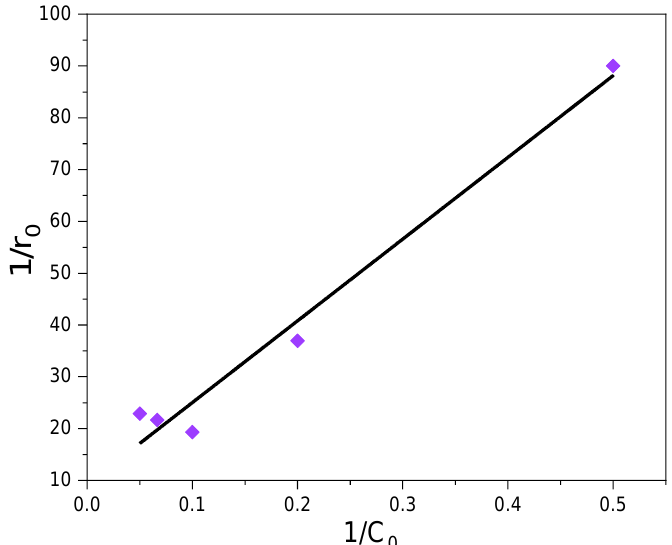
Figure 9. Linear correlation of 1/r 0 versus 1/C 0.